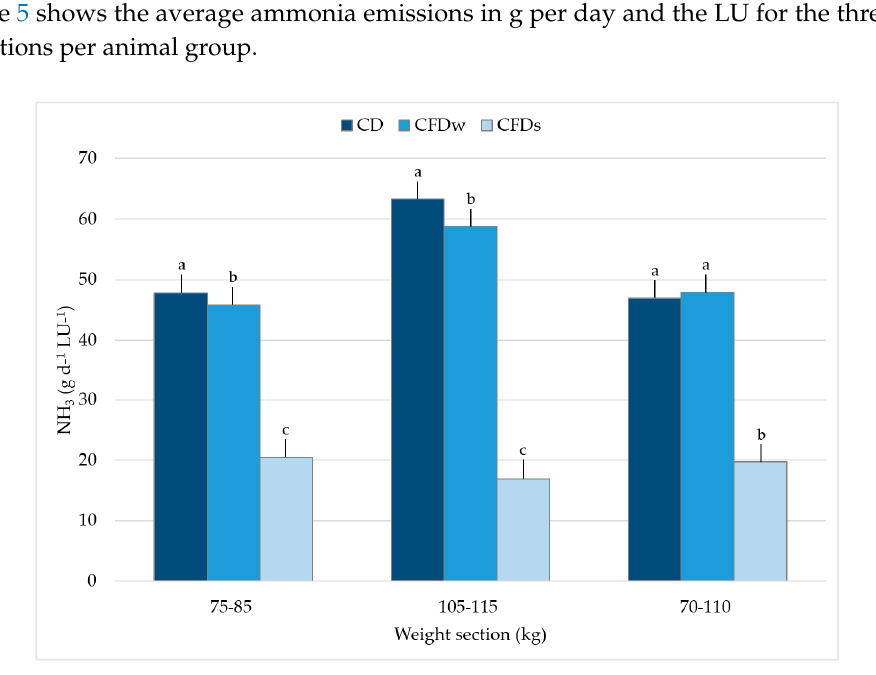
Figure 5. Ammonia emissions per day and livestock unit as influenced by the diet (CD = control diet;